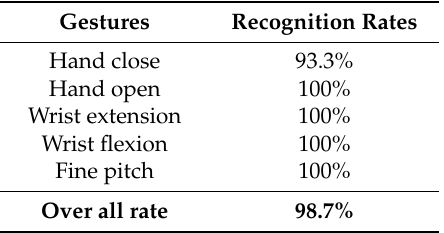
Table 3. Recognition rates on segmented hand images.